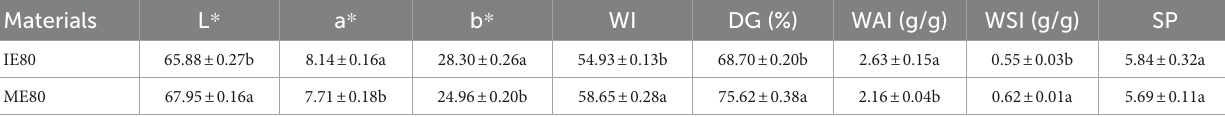
TABLE 3 The color attributes, DG and hydration characteristics of different instant powder samples. Materials